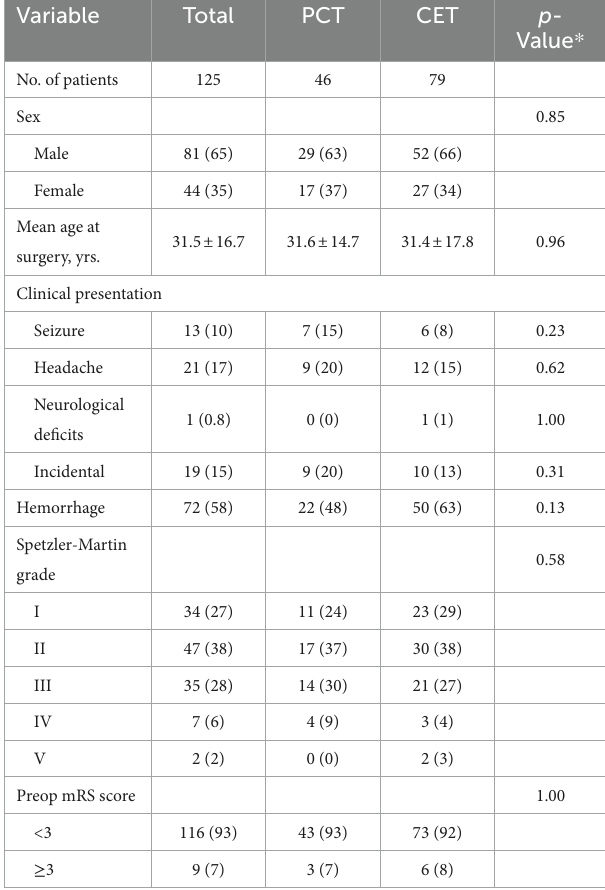
TABLE 1 Patient and bAVM